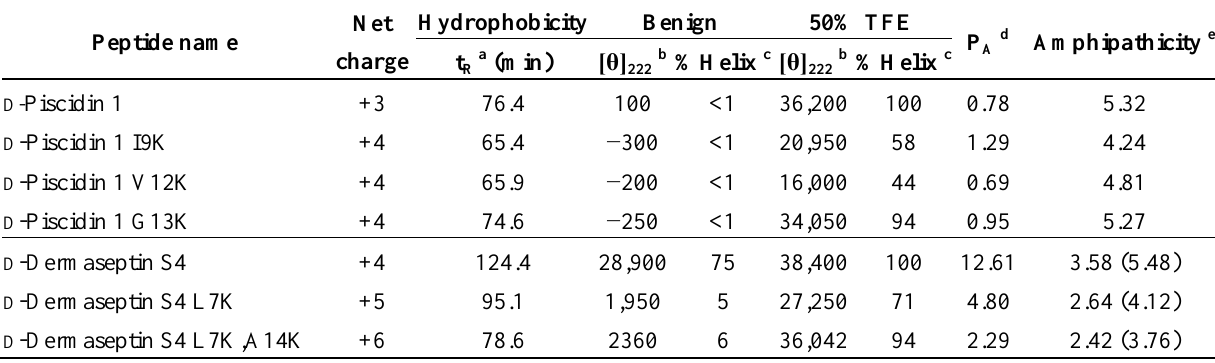
Table 2. Biophysical